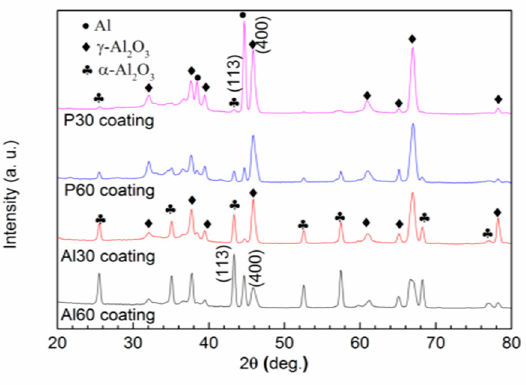
Figure 4. XRD patterns of the surface coatings prepared from different electrolytes with different treating time.